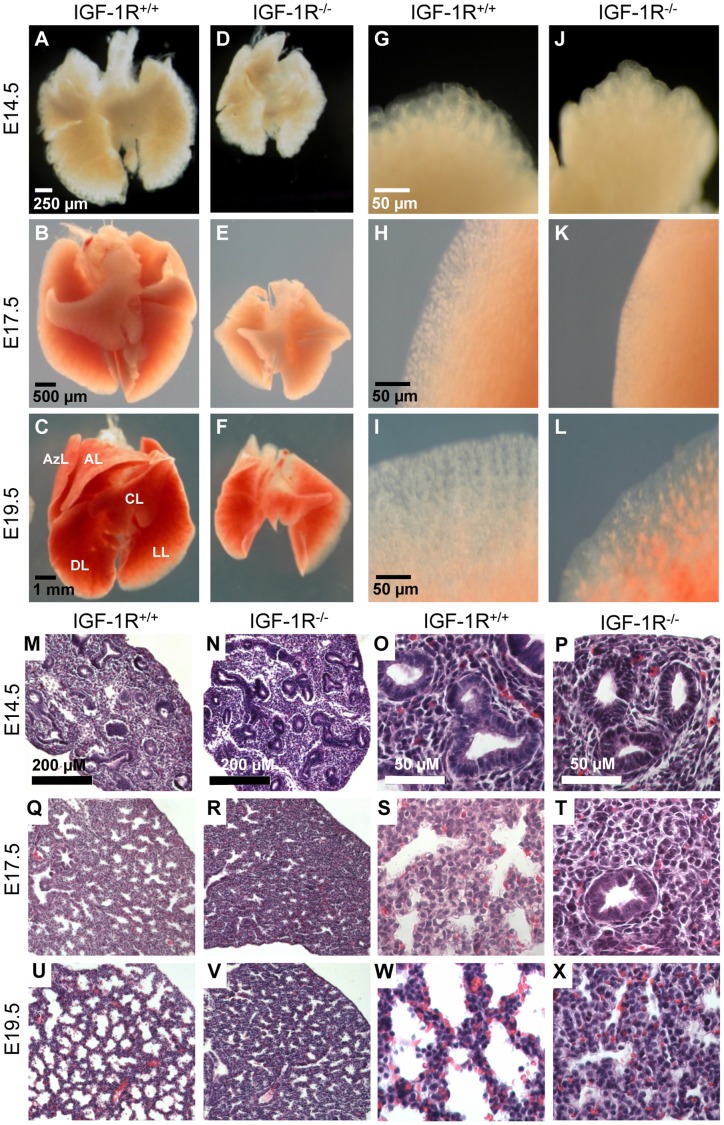
Lung development in late gestation IGF-1R−/− mice.
A–L, Lungs prepared from IGF-1R+/+ and IGF-1R−/− embryos at developmental stages E14.5, E17.5 and E19.5. A–F, Ventral view of whole lungs. G–L, Rim of lung lobe. Abbreviations: AL, apical lobe; AzL, azygous lobe; CL, cardiac lobe; DL, diaphragmatic lobes; LL, left lobe. M–X, Lung histology of IGF-1R+/+ versus IGF-1R−/− embryos. H&E stained lung sections at developmental stages E14.5 (M–P), E17.5 (Q–T) and E19.5 (U–X), showing that saccular walls are thicker and acinar buds smaller in IGF-1R−/− embryos as compared with controls of the same stage. Note that histomorphological appearance is similar when comparing E19.5 IGF-1R−/− (V, X) with two days younger E17.5 IGF-1R+/+ lungs (Q, S).